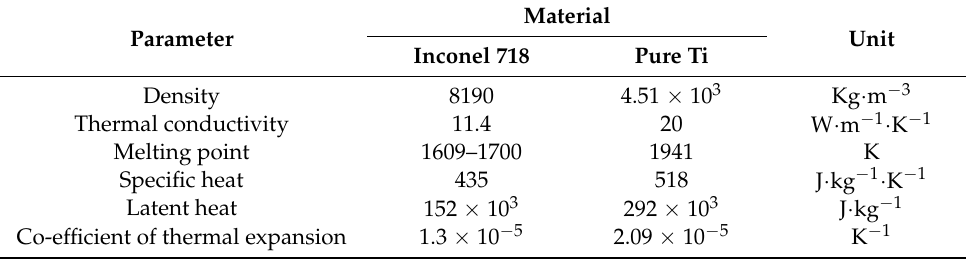
Table 2. Material properties of Ti and Inconel 718 used in the present work Table 1. LAM processing parameters for pure Ti Inconel 718 material.